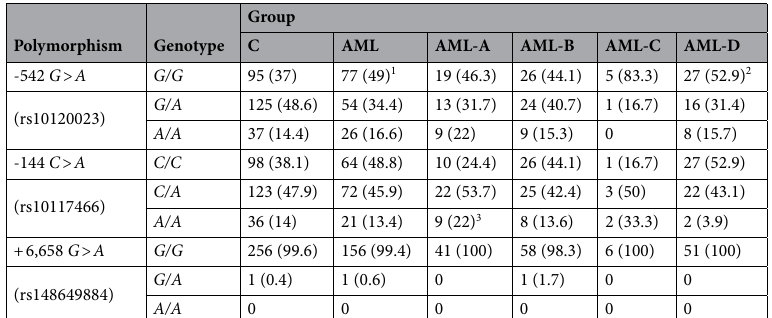
Table 1. Frequency of genotypes associated with selected FCN1 single nucleotide gene polymorphisms. Percentages are shown in parentheses. Allele distributions were in accordance with Hardy–Weinberg equlibrium, with an exception for − 542 G > A polymorphism in AML group where G/G homozygosity was more common than predicted. C: controls; AML-A: patients who experienced infections with proven bacteremia and/or fungaemia; AML-B: patients who experienced infections with no bacteremia; AML-C: patients who experienced febrile neutropenia; AML-D: patients who experienced none of afore-mentioned complications within 4 weeks of hospital stay. 1 p = 0.018, OR = 1.6, 95% CI (1.1–2.45) (vs. C) [multiple logistic regression, dominant model: p = 0.004, OR = 2.95, 95% CI (1.41–6.16)]. 2 p = 0.041, OR = 1.9, 95% CI (1.05–3.51) (vs. C). 3 p = 0.01, OR = 6.9, 95% CI (1.4–33.98) (vs.